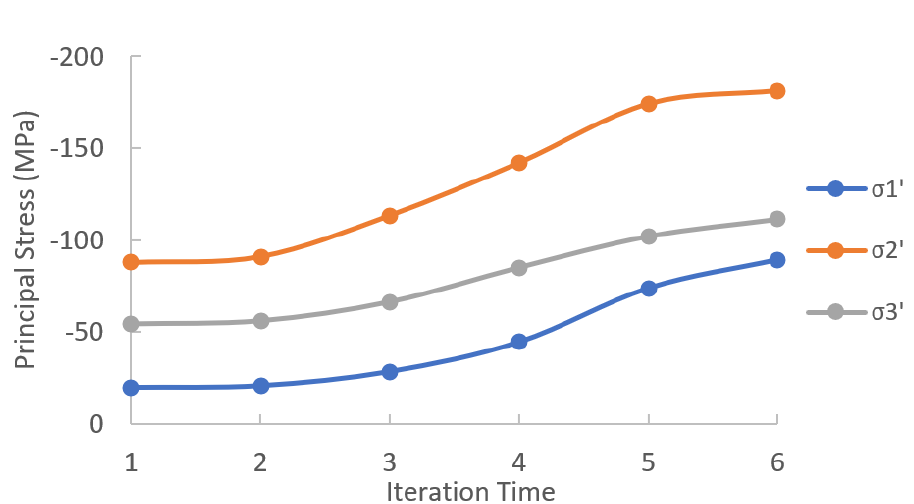
Figure 9. Changing of breakout region in the process of breakouts. From Table 3 and Figures 7 – 9, the principal stresses of elements close to the tip of wellbore breakouts are increasing in the process of breakouts, but the maximum tensile strain changes to less than 𝜀 𝑏𝑟𝑒𝑎𝑘𝑜𝑢𝑡 . As a breakout develops, the breakouts depth in- creases and the breakout width decreases, which means the depth of breakouts increases till a stable state, but the width of breakouts remains unchanged [3]. 3.3. Influence of Drilling Fluid Temperature For a vertical well shown in Figure 3, associated with horizontal in situ stresses 𝜎 𝐻 = 85 MPa, 𝜎 ℎ = 72.5 MPa, and the temperature difference between drilling fluid and sur- rounding rock ∆𝑇 = −50~50K , and other parameters are listed in Table 1, the breakout shape for different drilling fluid temperature is shown in Figure 10.